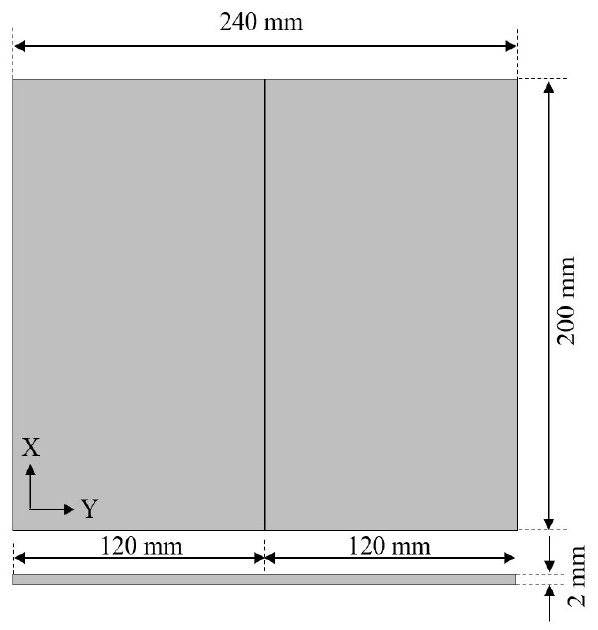
Figure 2. CMT molten pool flow substrate size.